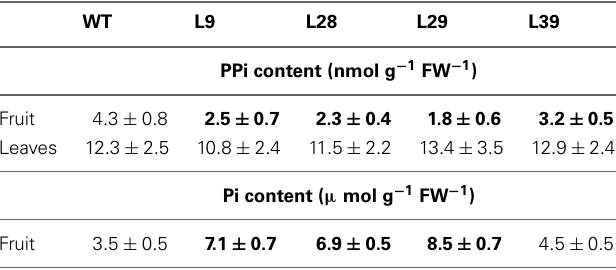
Table 1 | Pyrophosphate and inorganic phosphate concentration in the B33-PPi red tomato fruits (60 DAP) and leaves (3 weeks old